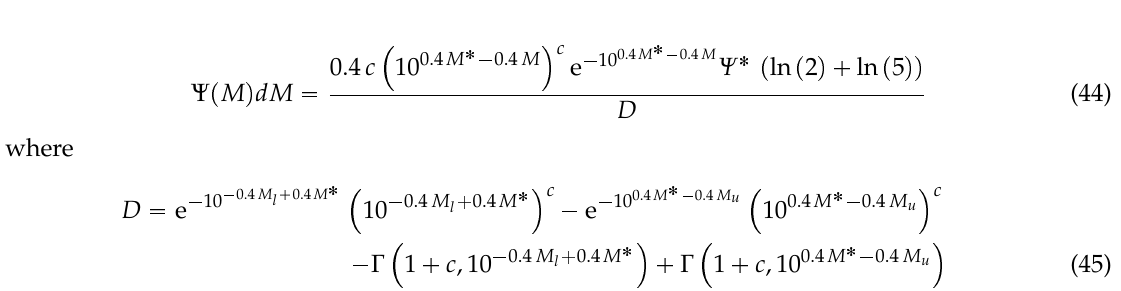
23.73, M u = 17.48, M (cid:6) = 21.1, Ψ (cid:6) 0.04 Mpc (cid:1) 3 and c 0.02. The dotted (cid:1) (cid:1) (cid:1) (cid:16) (cid:16) 0.013 Mpc (cid:1) 3 and α (cid:16) (cid:16) (cid:1)